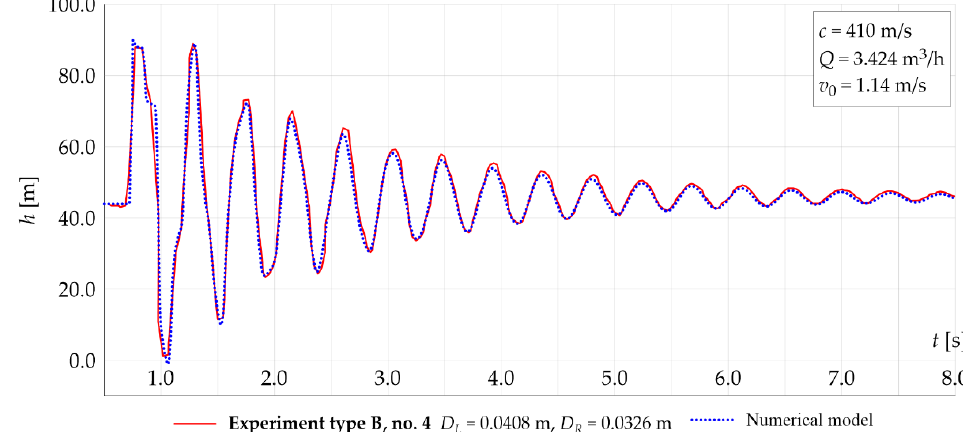
9 of 13 Figure 5. Calculated and observed pressure oscillations during experiment no. 2.